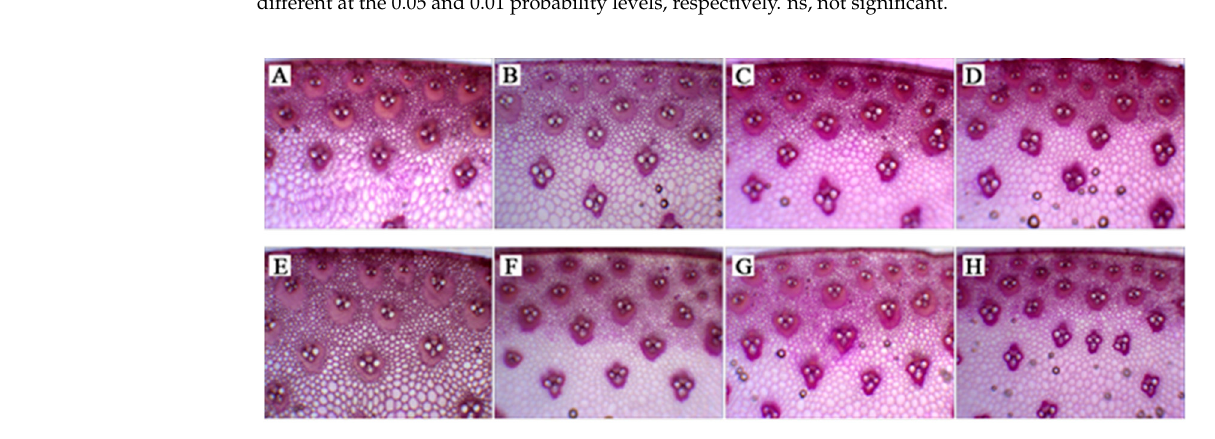
Figure 4. Lateral section of the third basal internodes of stem (×40) in 2014. ( A – D ) represent 1.5, 6.0, 7.5, 9.0 × 10 4 plants ha − 1 for DH618, respectively; ( E – H ) represent 1.5, 6.0, 7.5, 9.0 × 10 4 plants ha − 1 for XY335, respectively. Table 7. Stem micro-structure of DH618 and XY335 under different planting densities in 2014.